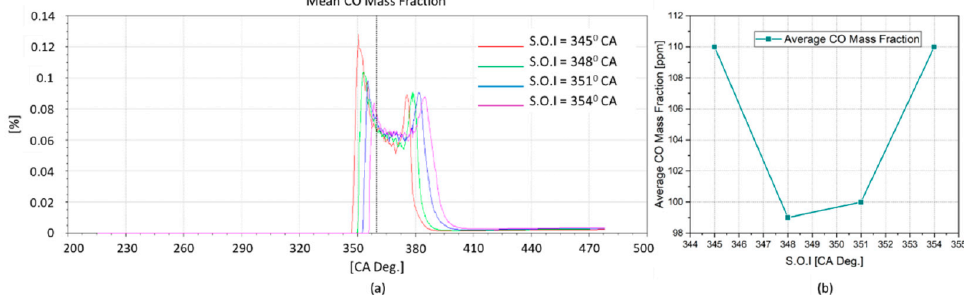
Figure 26. Mean CO mass fraction diagrams ( a ) and the average CO mass fraction ( b ) according to the change of S.O.I angle in the diesel mode.